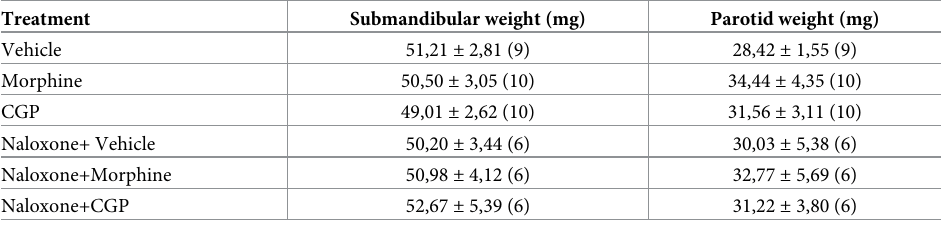
CGP, cyclo-Gly-Pro. P > 0.05 vs. vehicle. One-way ANOVA, Student-Newman-Keuls as post hoc